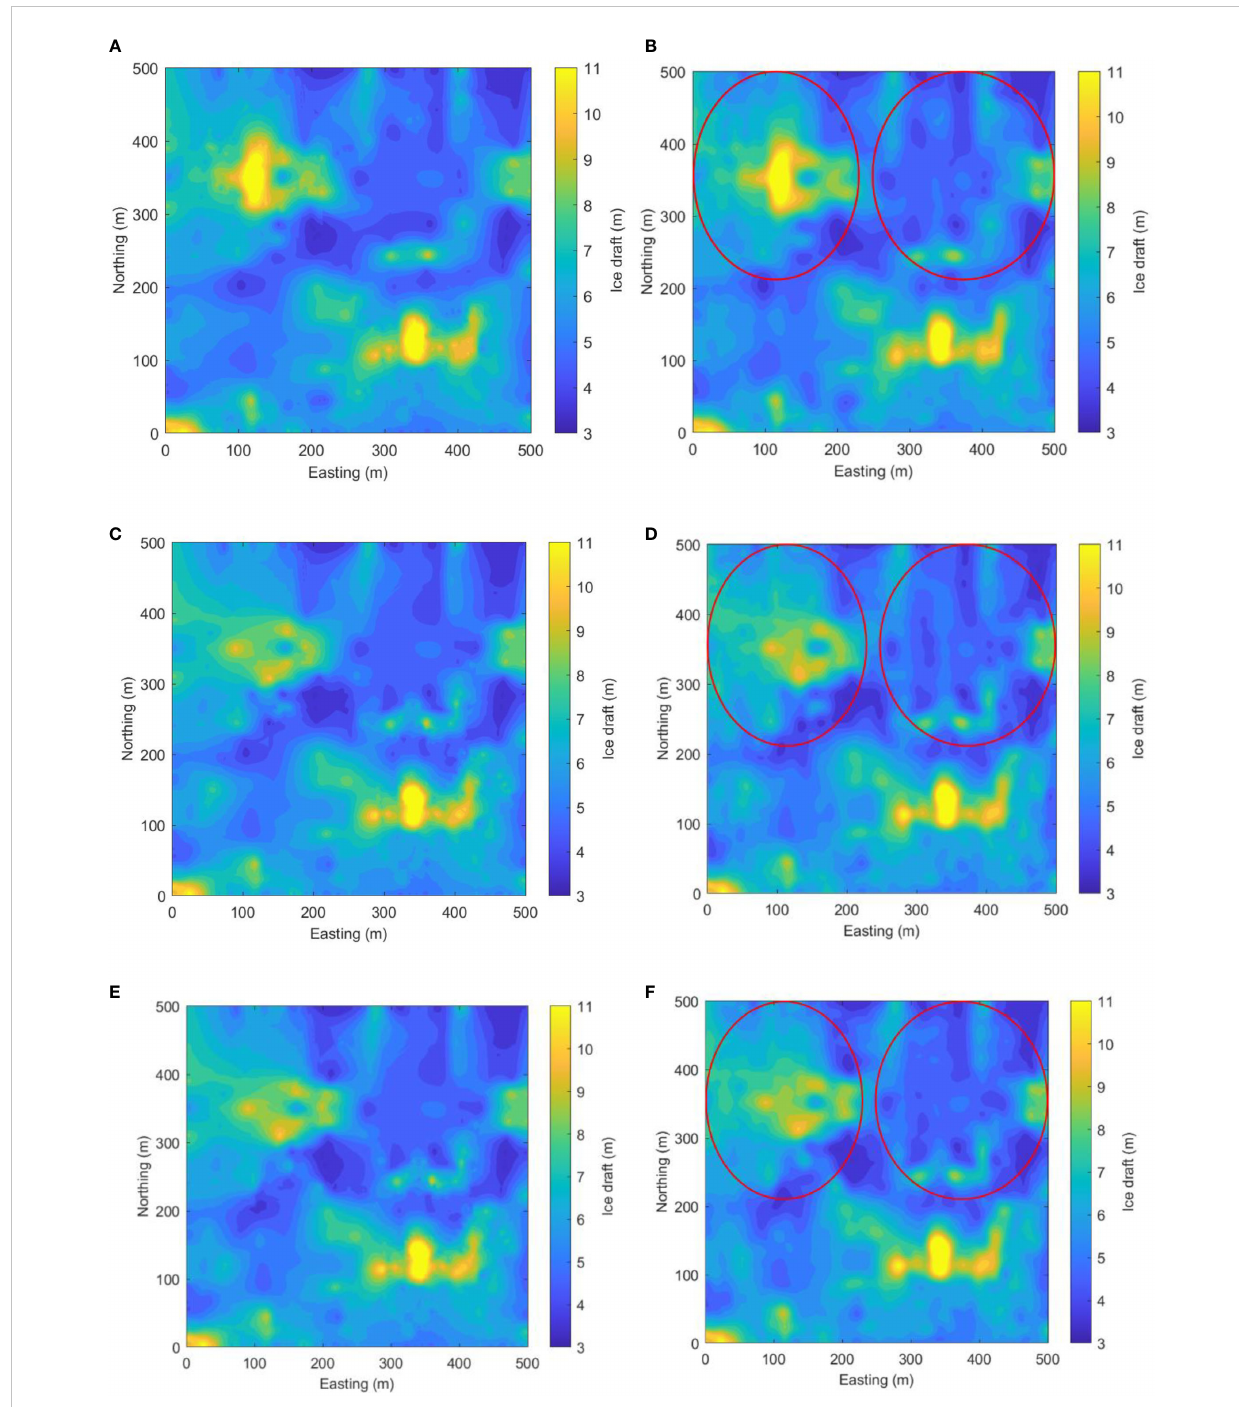
FIGURE 10 Reconstructed ice draft map by different adaptive mapping and reconstruction methods (Red ellipses indicate the area for performance comparison). (A) Kriging interpolation under ice draft criterion. (B) Sparse approximation under ice draft criterion. (C) Kriging interpolation under ice draft gradient criterion. (D) Sparse approximation under ice draft gradient criterion. (E) Kriging interpolation under ice draft entropy criterion. (F) Sparse approximation under ice draft entropy